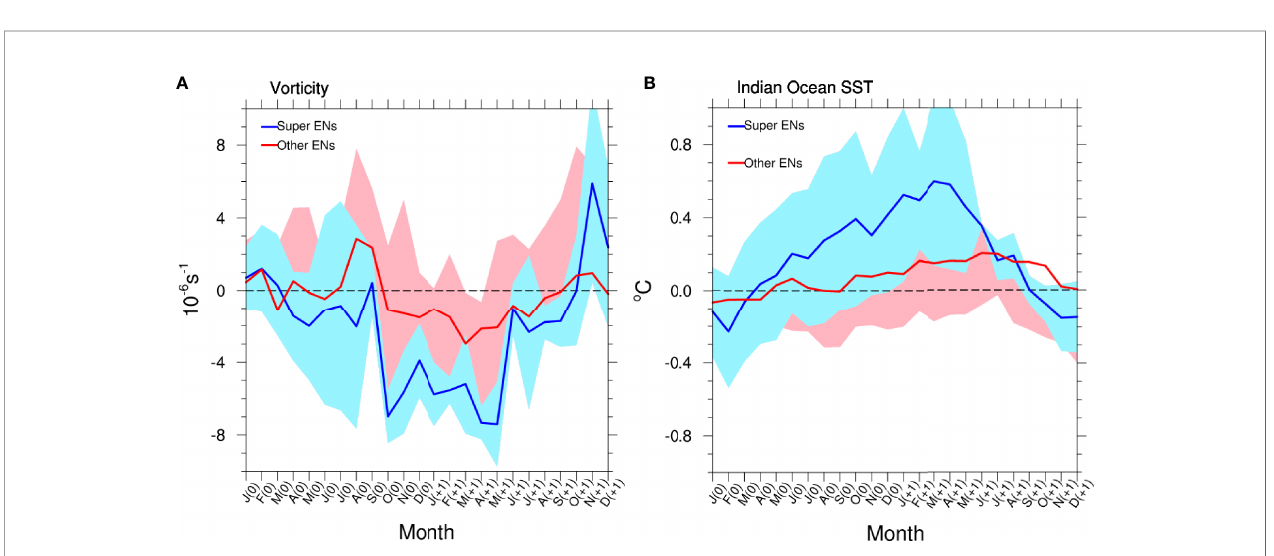
FIGURE 12 | (A) The blue and red lines indicate the vorticity anomalies averaged over the SCS for super and other El Niño composite, respectively. (B) Same as in (A) but for the SST anomalies over the Indian Ocean (20°S – 20°N, 40 – 100°E). Shading indicates ±1 standard deviations of every